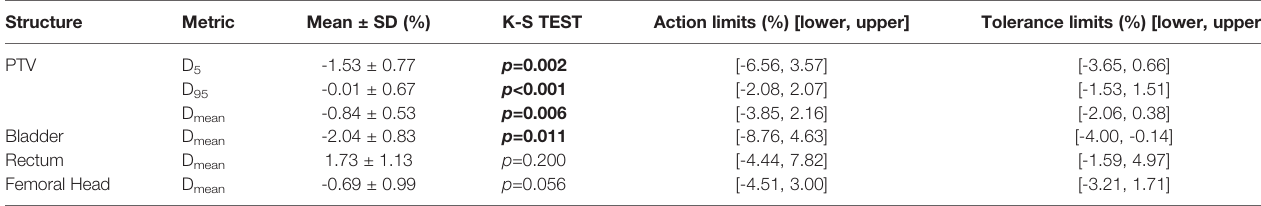
TABLE 2 | A list of DVH action levels obtained by statistical process control for each structure in RapidArc cervical cancer plans. Structure